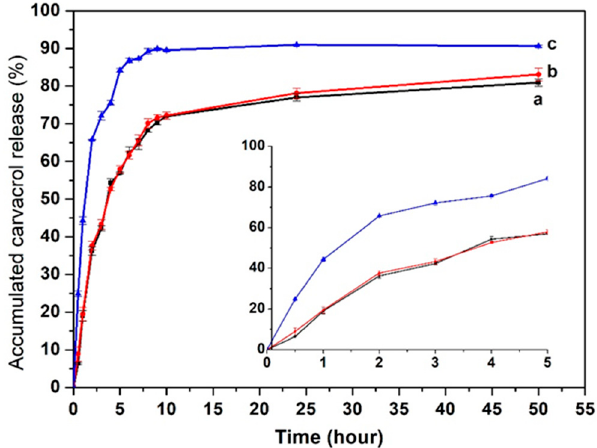
Figure 3. Release profiles of carvacrol from SLNs with a carvacrol loading at 30% mass of lipids and a PGMP:GMS mass ratio of 2:1 ( b ) or 1:1 ( a ), with comparison to free carvacrol dissolved in ethanol ( c ). The inset figure shows release kinetics in the first 5 h. The released carvacrol was detected in the release medium outside the dialysis bag. Error bars are standard derivations ( n = 3).